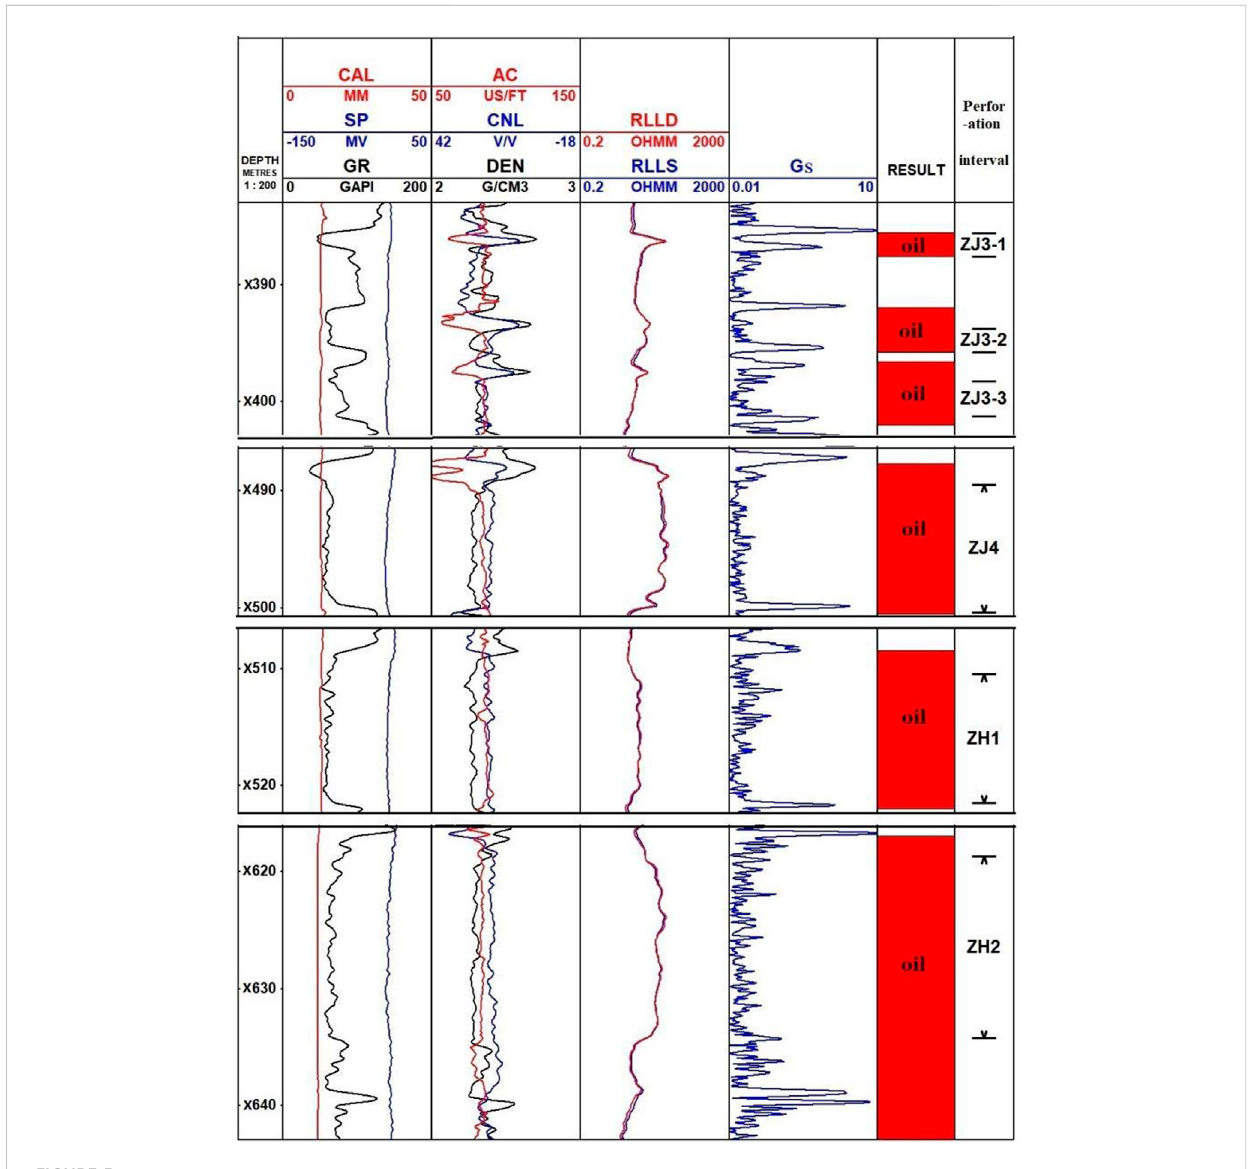
FIGURE 5 Result fi gure of the G S of the main oil reservoir of well